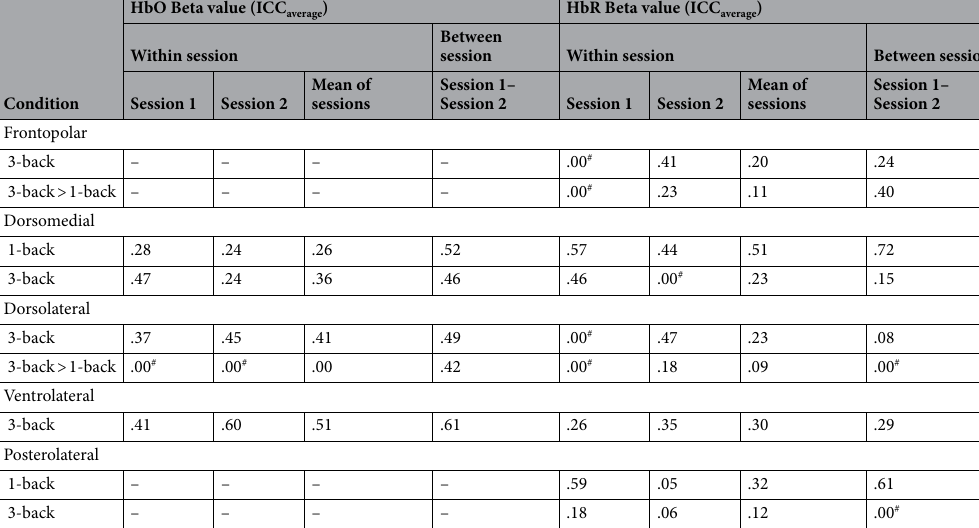
Table 7. Intraclass correlation coefficients (ICCs) of changes in oxyhemoglobin (HbO) and deoxyhemoglobin (HbR) concentrations. ICC was calculated for significant contrasts only. Within-session reliability was indicated by the ICC of beta values among the three task blocks, whereas between-session reliability was represented by the ICC of the overall beta values between the two sessions. ICCs of at least 0.40, indicating fair consistency or above, were underlined. # Negative ICCs were set to